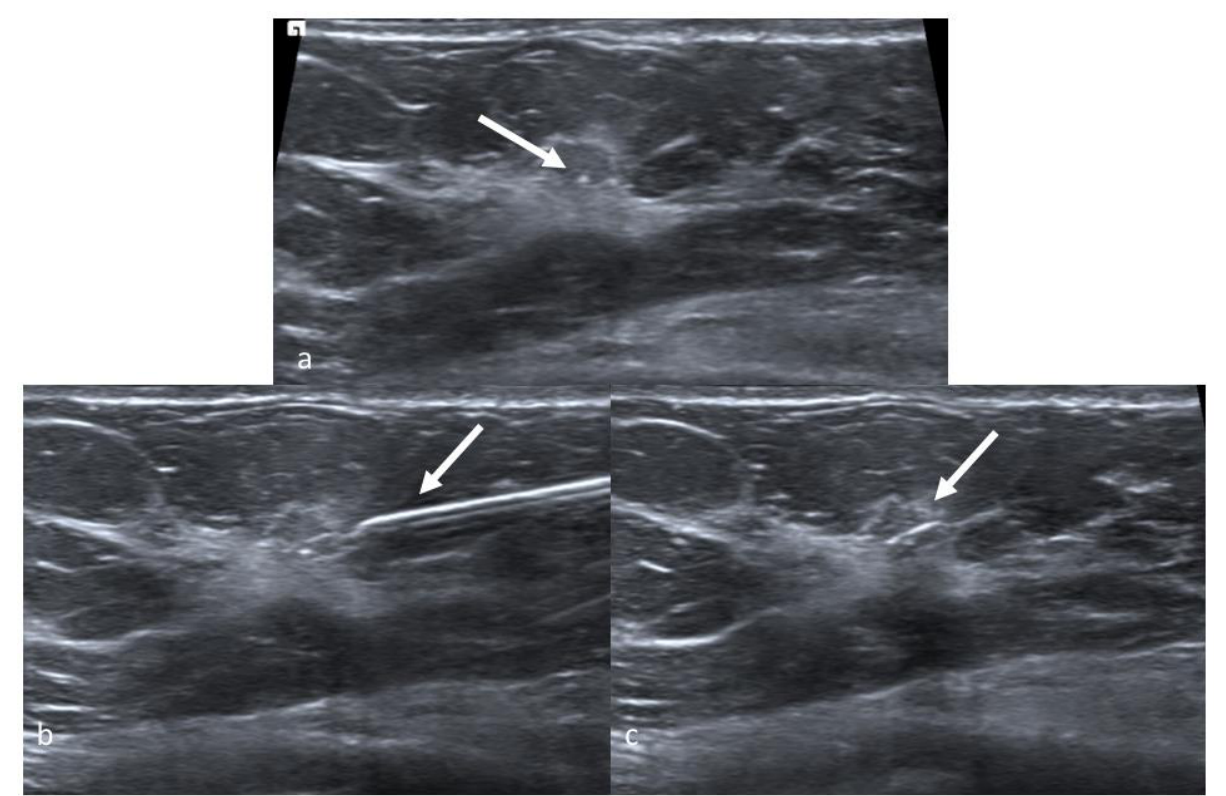
Figure 3. Magseed positioning in a 49-year-old woman with ductal carcinoma in situ. Ultrasound images of the right upper outer quadrant. Biopsy marker is visible in the lesion ( a , arrow). Magseed magnetic marker is placed under ultrasound guidance ( b , arrow shows the needle). Magseed ® marker is clearly seen in the lesion ( c , arrow).